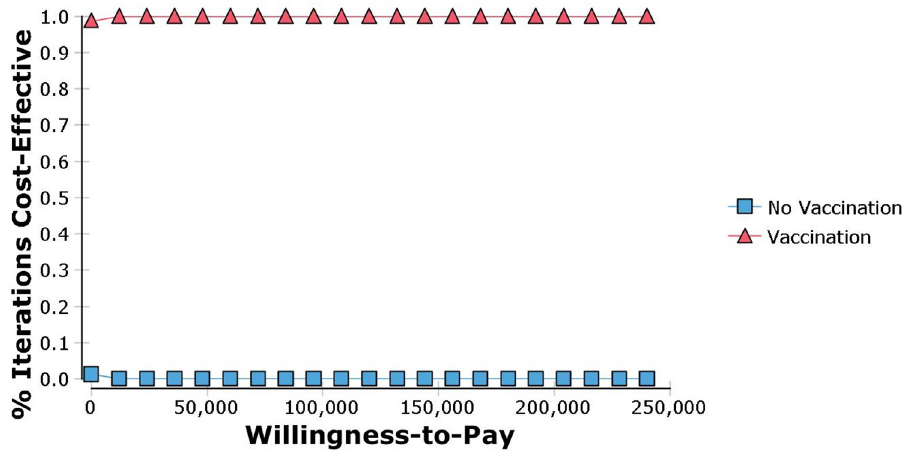
Fig 4. Cost-effectiveness acceptability curve showing the probability that vaccination is cost-effective compared to no vaccination over a range of